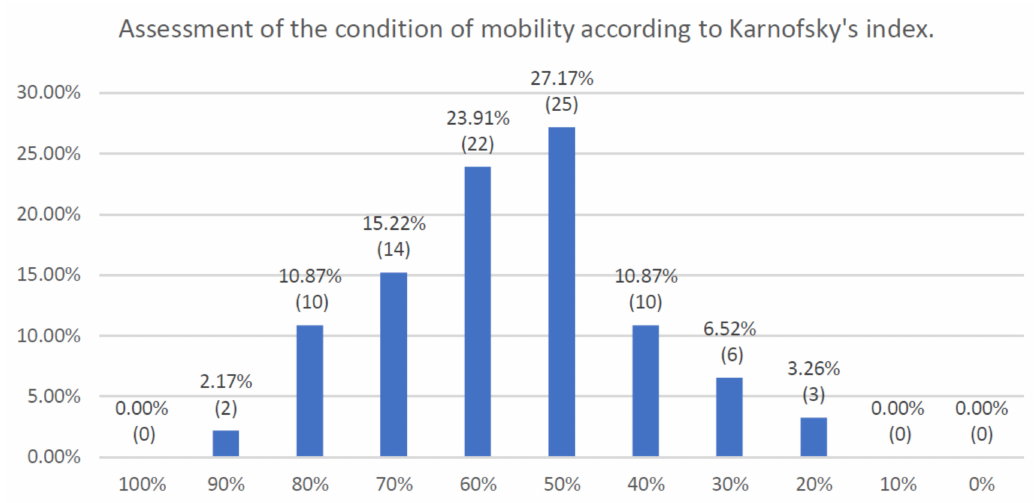
Figure 1. Assessment of the condition of mobility according to Karnofsky’s index.